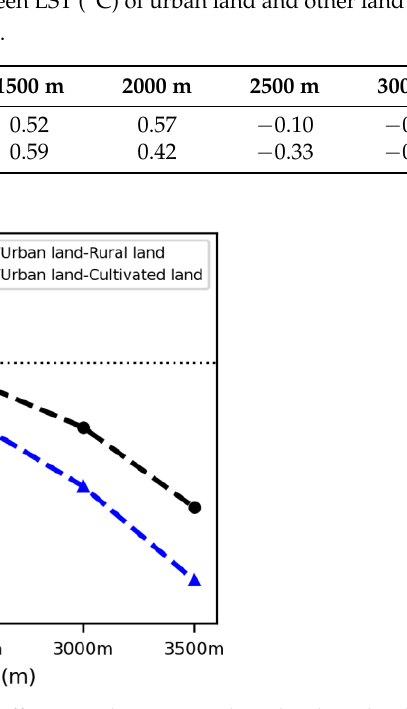
Figure 6. Variations of LST (°C) differences between urban land and other land use types with ele- vation.